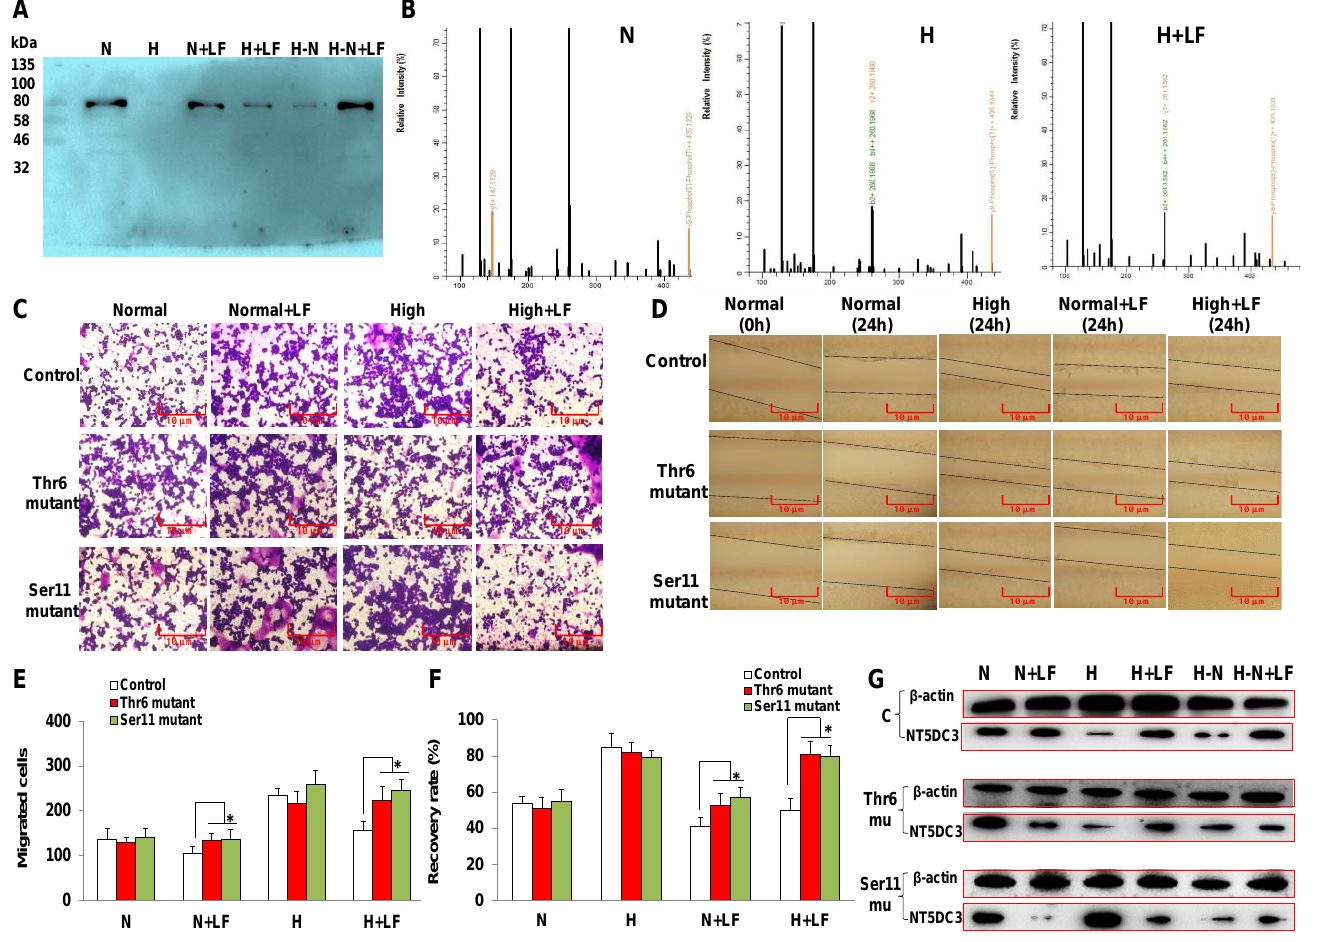
Figure 3. Phosphorylation site investigation in the NT5DC3 protein. ( A ) CoIP gel of the NT5DC3 protein, obtained via Western blotting. ( B ) Phosphorylation at Thr6 and Ser11, determined via secondary mass spectrometry. ( C ) Images of the invaded HT29 cells in the Transwell experiment p(200 × ). ( D ) Images of the migrated HT29 cells obtained via a scratch assay (200 × ). ( E ) Statistical analysis of the invaded HT29 cells. ( F ) Statistical analysis of the migrated HT29 cells. ( G ) NT5DC3 protein expression in the HT29 cells obtained via Western blotting. The data are presented as mean ± SD, * p < 0.05 compared with the control group. This experiment was repeated three times ( n = 3).